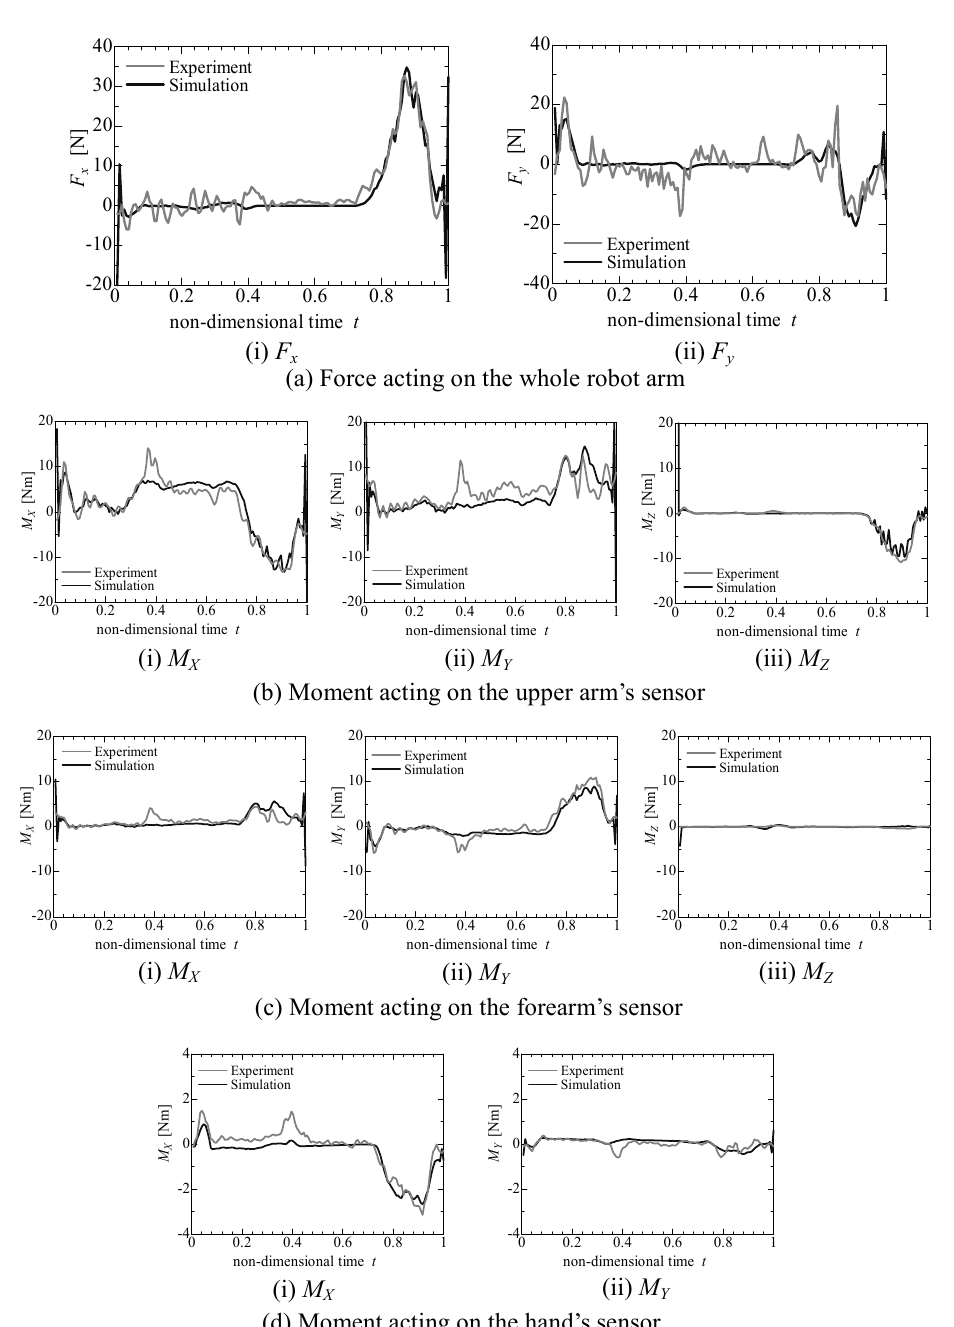
Fig. 11 Comparison between experiment and simulation results in the crawl I upper and experimental results are shown in Fig. 11. Three forces measured by the dynamometer, bending moments at the shoulder, elbow and wrist are shown in Fig. 11(a), (b), (c) and (d), respectively. The abscissa, t , is the nondimensional time by which one cycle becomes 1. The gray and black lines represent the experimental and simulated results, respectively. The timing t = 0.4 corresponds to the water entry, t = 0.8~0.9 the pull motion, t = 0.9~1.0 the push motion, and t = 1.0 the finish. It was found that the simulated results were sufficiently consistent with the experimental results during the period that the arm is underwater. At the timing of the water entry ( t = 0.4), the error became larger. The reason for this is that the motion of the robot arm at the entry became somewhat unnatural due to mechanical limitation. The simulated results largely deviated from the experimental ones at t = 0 and 1.